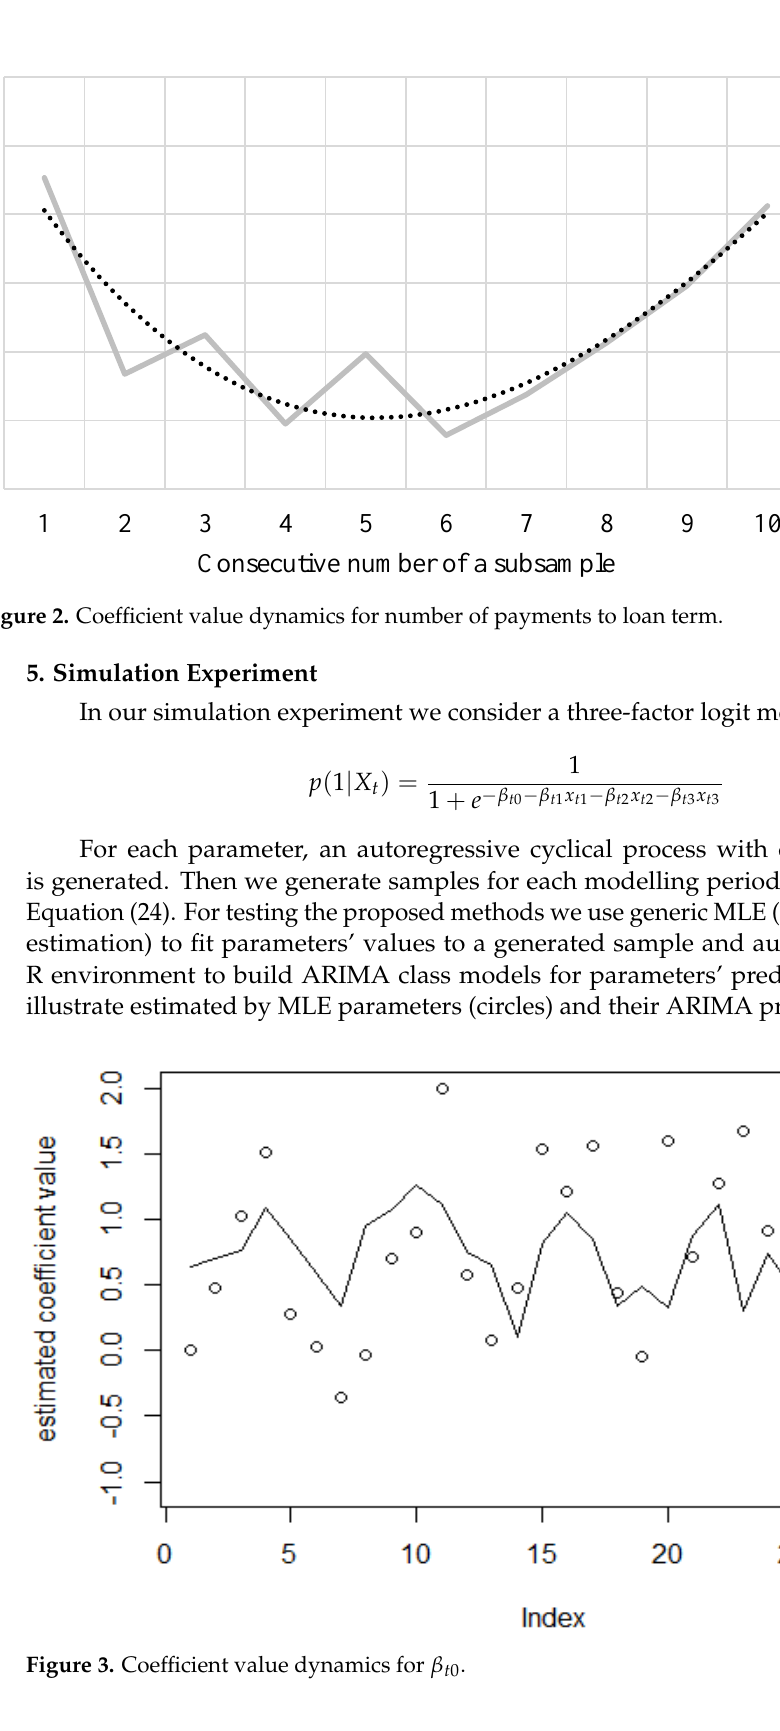
Figure 2. Coefficient value dynamics for number of payments to loan term.